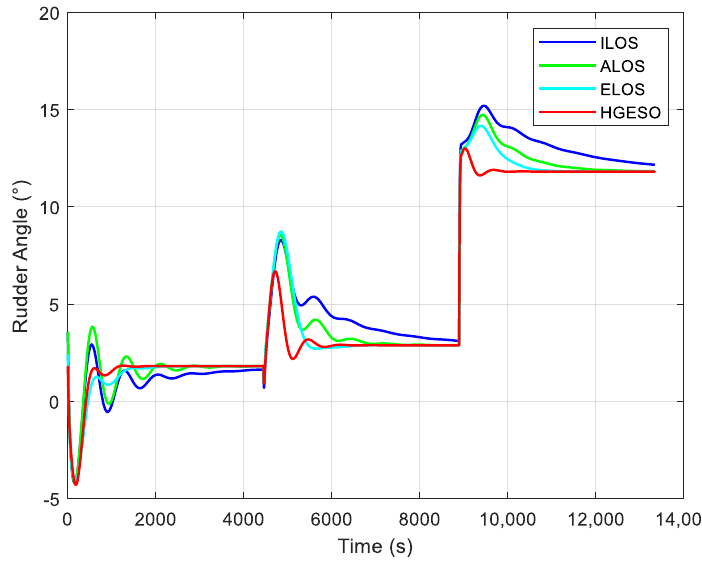
Figure 8. Comparison of rudder angle in different guidance laws at y d = 0.05 L